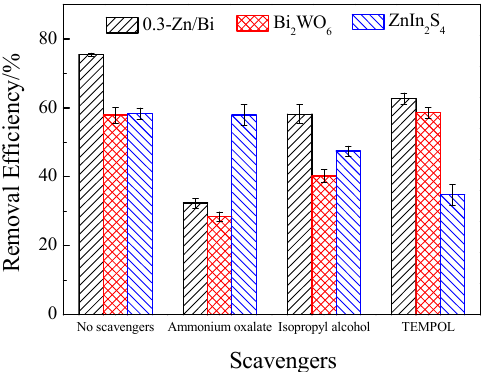
Figure 6. Removal of fluvastatin by as-prepared photocatalyst in the presence of various scavengers: isopropyl alcohol (1ml/L), ammonium oxalate and TEMPOL (1 mmol/L).